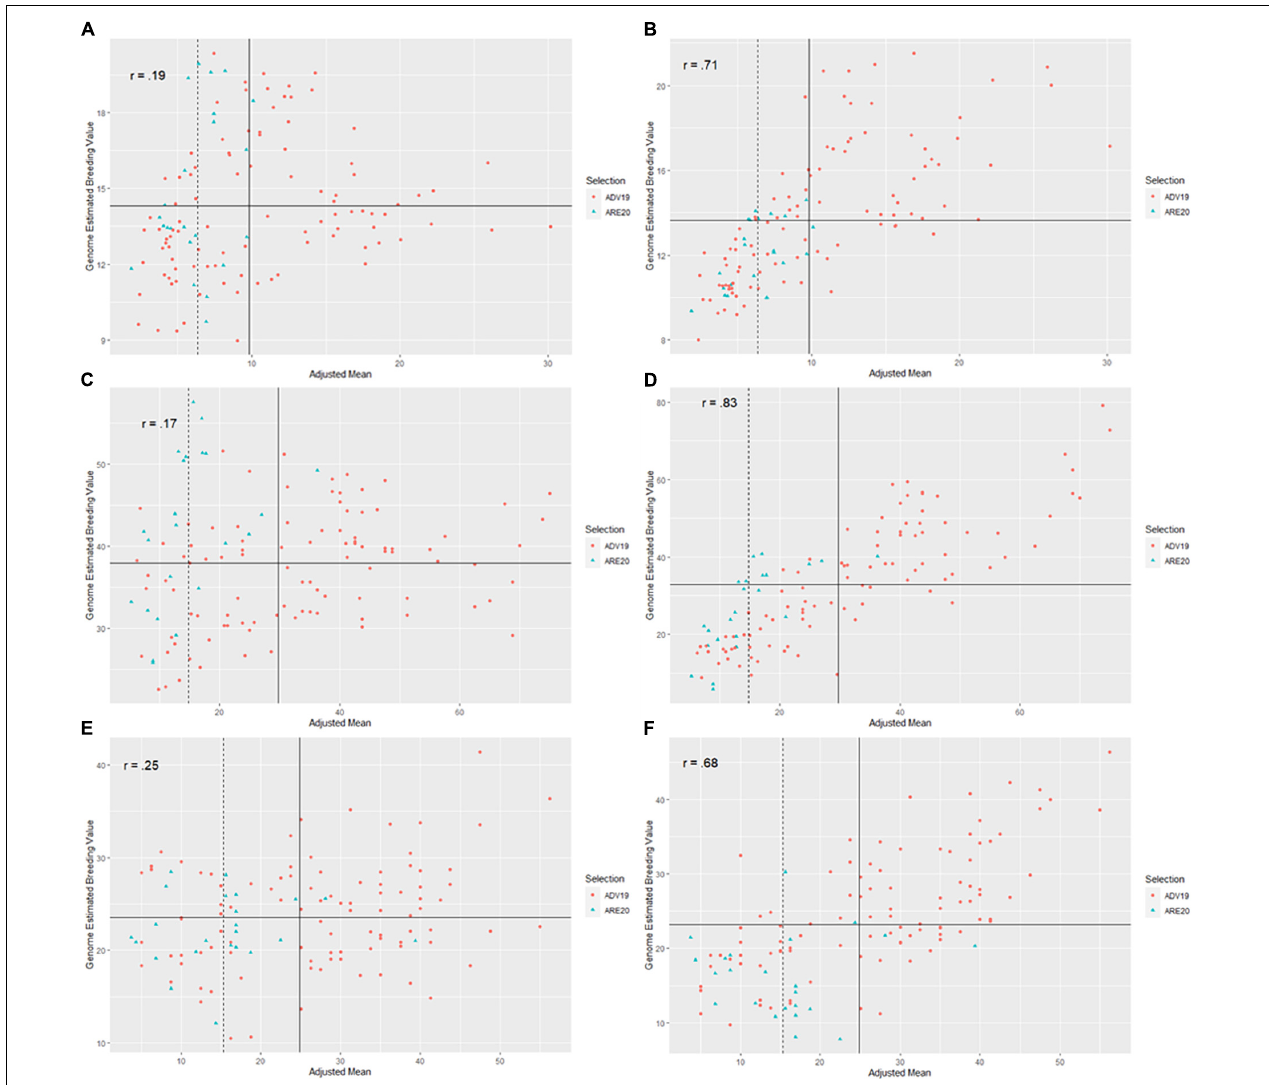
FIGURE 4 | Scatter plots between genome-estimated breeding values (GEBVs) for three Fusarium head blight (FHB) resistance traits in soft red winter wheat from two different genomic selection models (GS), including naïve models without covariates (NGS) and multi-trait GS models with covariates (MTGS), and adjusted means for deoxynivalenol (DON) concentration, Fusarium damaged kernels (FDK), and severity (SEV) across two generations, F 4 : 7 advanced from 2018 to 2019 (ADV19) and F 4 : 8 elite from 2019 to 2020 (ARE20): (A) predictions for DON in ADV19 using a NGS model, (B) predictions for DON using a MTGS model, (C) predictions for FDK from ADV19 using a NGS model, (D) predictions for FDK using a MTGS model, (E) predictions for SEV in ADV18 using a NGS model, (F) predictions for SEV using a MTGS model. The x -axis represents adjusted mean for DON, FDK, or SEV across the ADV and ARE generations. The y -axis represents the GEBVs calculated for DON, FDK, or SEV from the NGS or MTGS models. Different colored data points represent genotypes that were advanced to the next generation. The solid vertical line represents the mean of the adjusted means for the respective FHB resistance trait from the ADV generation, while the vertical dashed line represents the mean of the adjusted means for the respective FHB resistance trait from the ARE generations. The solid horizontal line represents the mean of GEBVs for the respective FHB resistance trait calculated from the NGS or MTGS models. The r label represents the Pearson correlation between GEBVs and adjusted